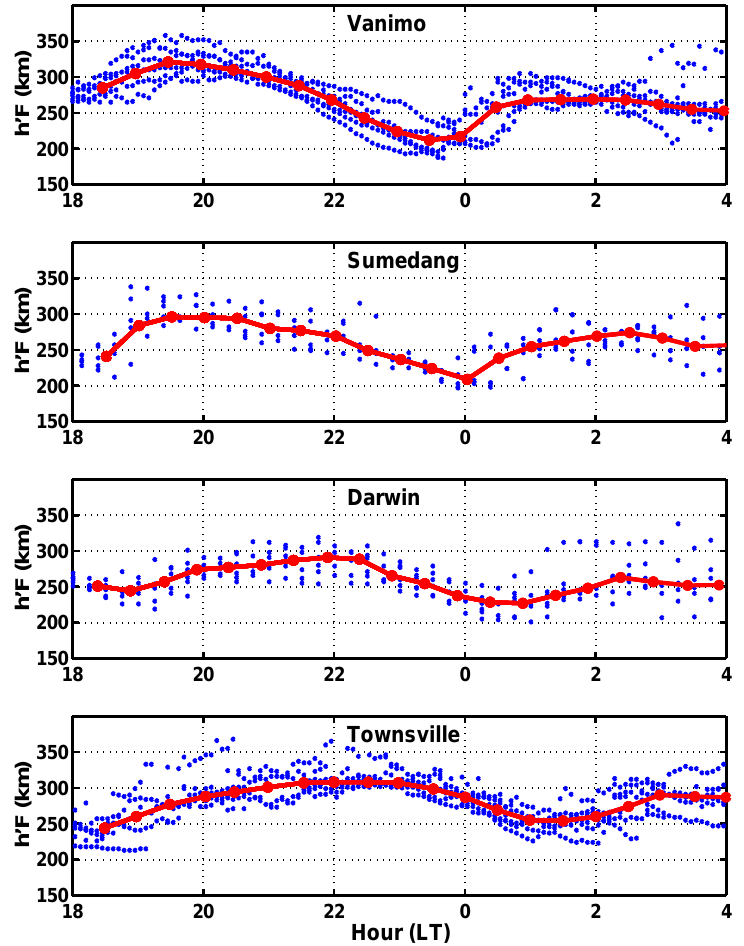
Fig. 6. Superimposed values of h 0 F (base ionospheric F2 virtual height) as a function of time showing the delay in the post sunset fall in height with increasing distance from the equator as observed over a number of days. Median values are shown in red.